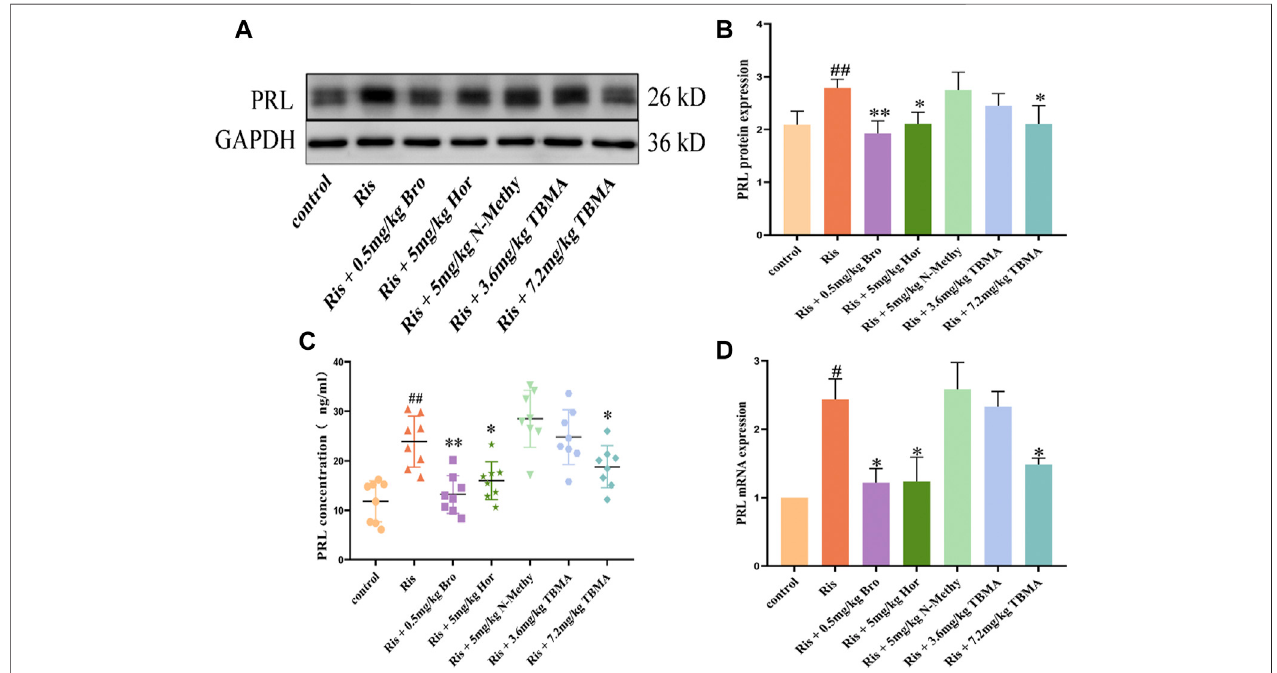
FIGURE3| EffectsofTBMA,hordenine,andN-methyltyramineonPRLexpression. (A,B) PRLproteinexpressiondeterminedbywesternblottingusingGAPDHas a loading control. Data are presented as the mean ± SD ( n = 3 rats per group). (C) PRL concentrations detected by ELIA ( n = 8). (D) PRL mRNA expression. mRNA expression wasdeterminedusingRT-PCR( n =3ratspergroup; # p < 0.05and ## p < 0.01versusthecontrolgroup; *p < 0.05and **p <